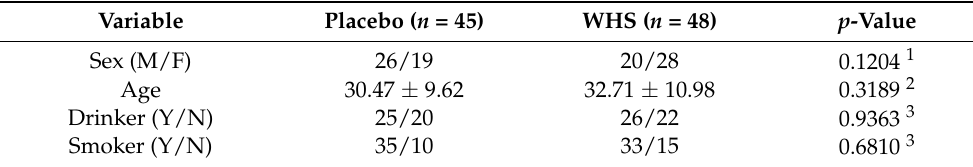
Table 1. Baseline demographic characteristics of the